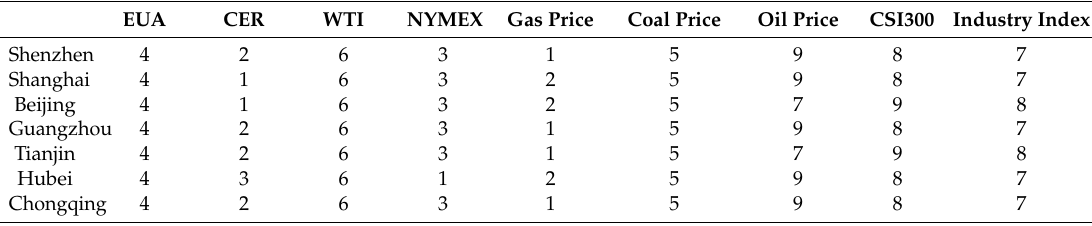
Table 8. Rank of the selected influence factors in IC-GRA